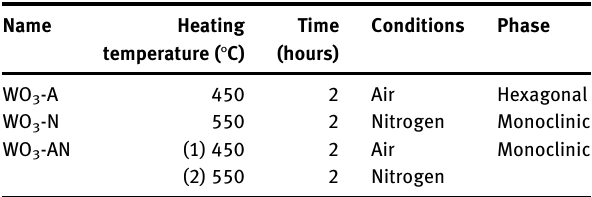
Table  : WO  synthesis conditions and structure [ 